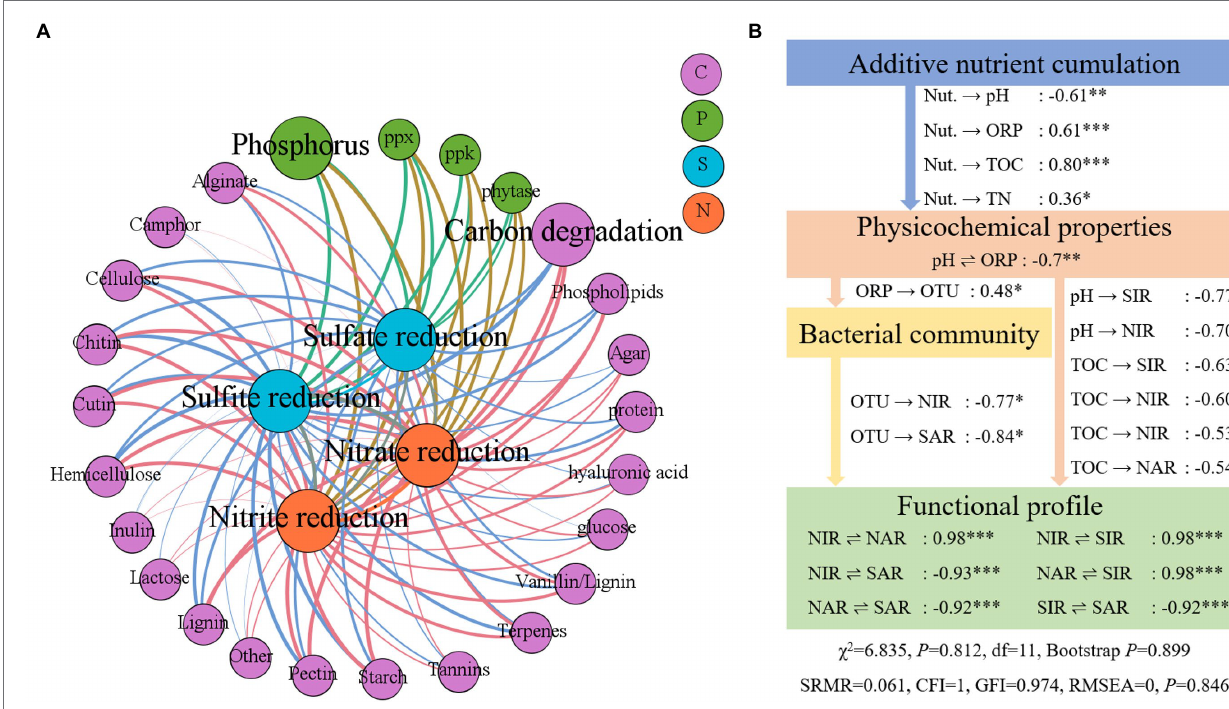
FIGURE 6 | Influence of added nutrients, environmental factors, bacterial community, and metabolism other elements on nitrogen and sulfur reduction gene structure. (A) Mantel test for genes involved in carbon degradation, phosphorus metabolism, and nitrogen and sulfur reduction. (B) A structural equation model (SEM) depicts the influence paths from added nutrients, environmental factors, and the bacterial community. NIR, nitrite reduction; NAR, nitrate reduction; SIR, sulfite reduction; SAR, sulfate reduction. * p < 0.05, ** p < 0.01, and *** p <